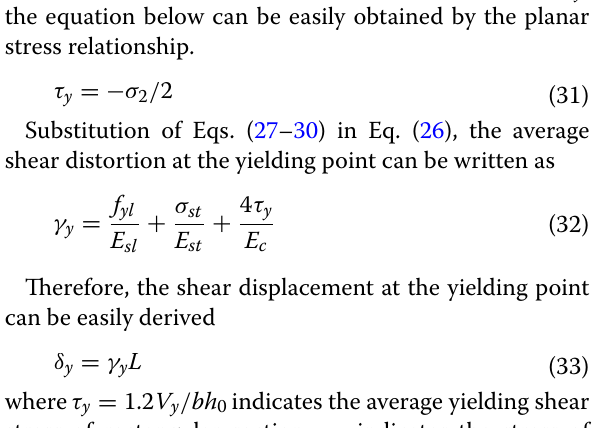
The stress–strain of concrete in the direction of prin- cipal compressive stress follows linear relation due to the principal compressive stress of concrete less than its peak stress. Assuming that the angle direction between princi- pal compressive stress of concrete and stirrups or longi- tudinal bars is 45°, the strain at the 45° is: